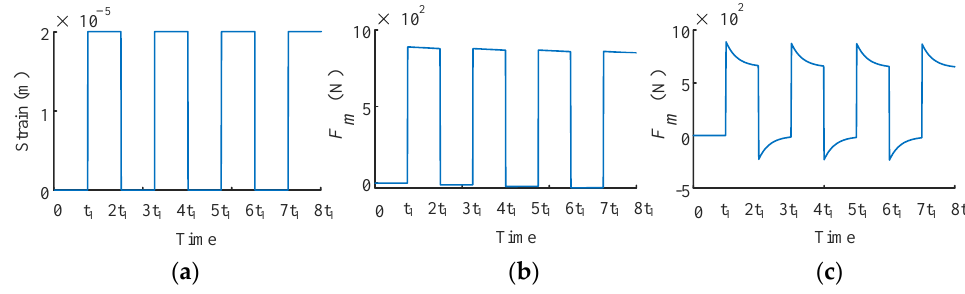
Figure 5. Frequency-dependent tooth force: ( a ) gear tooth deformation; ( b ) response of the tooth force when 𝑡 1 = 3 𝜏 1 ; ( c ) response of the tooth force when 𝑡 1 = 0.05 𝜏 1 .